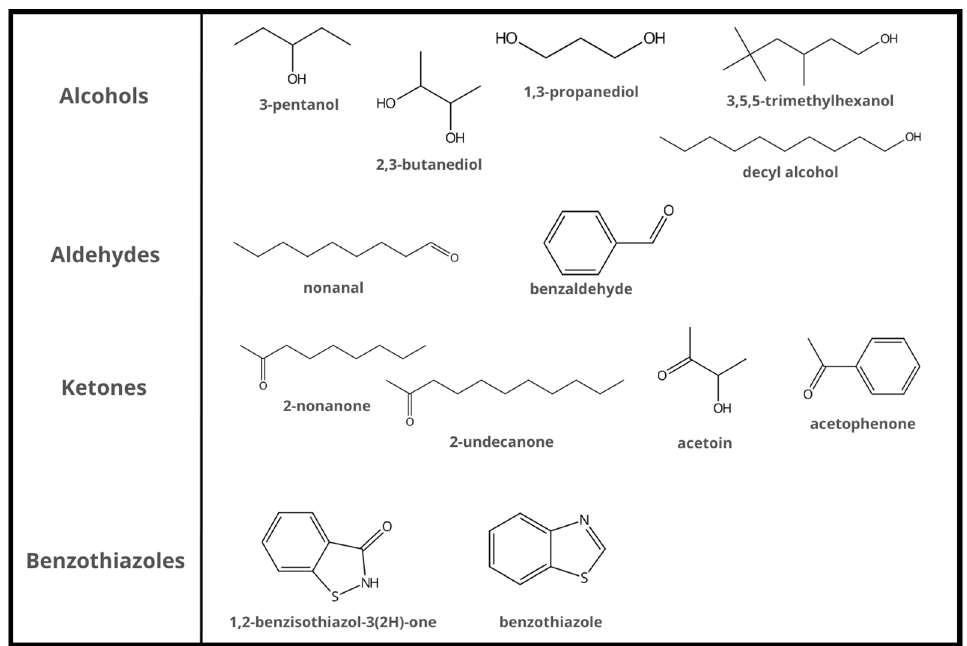
Figure 2. The most common antibacterial Bacillus ‐ based VOCs.